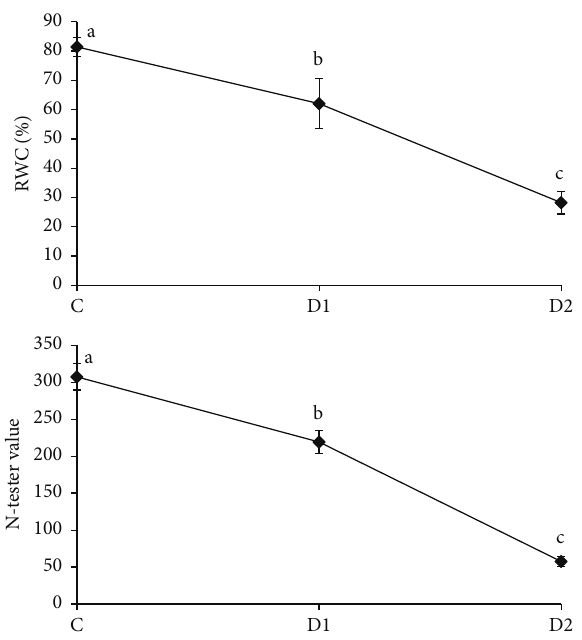
Figure 2: Effects of PEG levels (0, C; 2%, D1; and 4%, D2) on relative water content (RWC) and leaf chlorophyll content expressed as N- tester values of Thymus citriodorus. Values are mean ± SD of nine replicates.